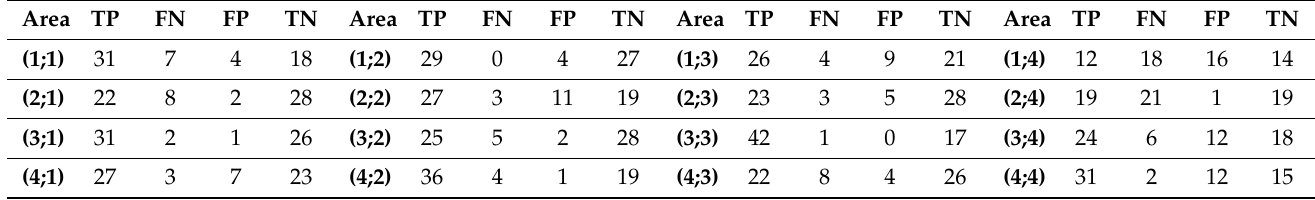
Table 5. TP, FN, FP e TN of